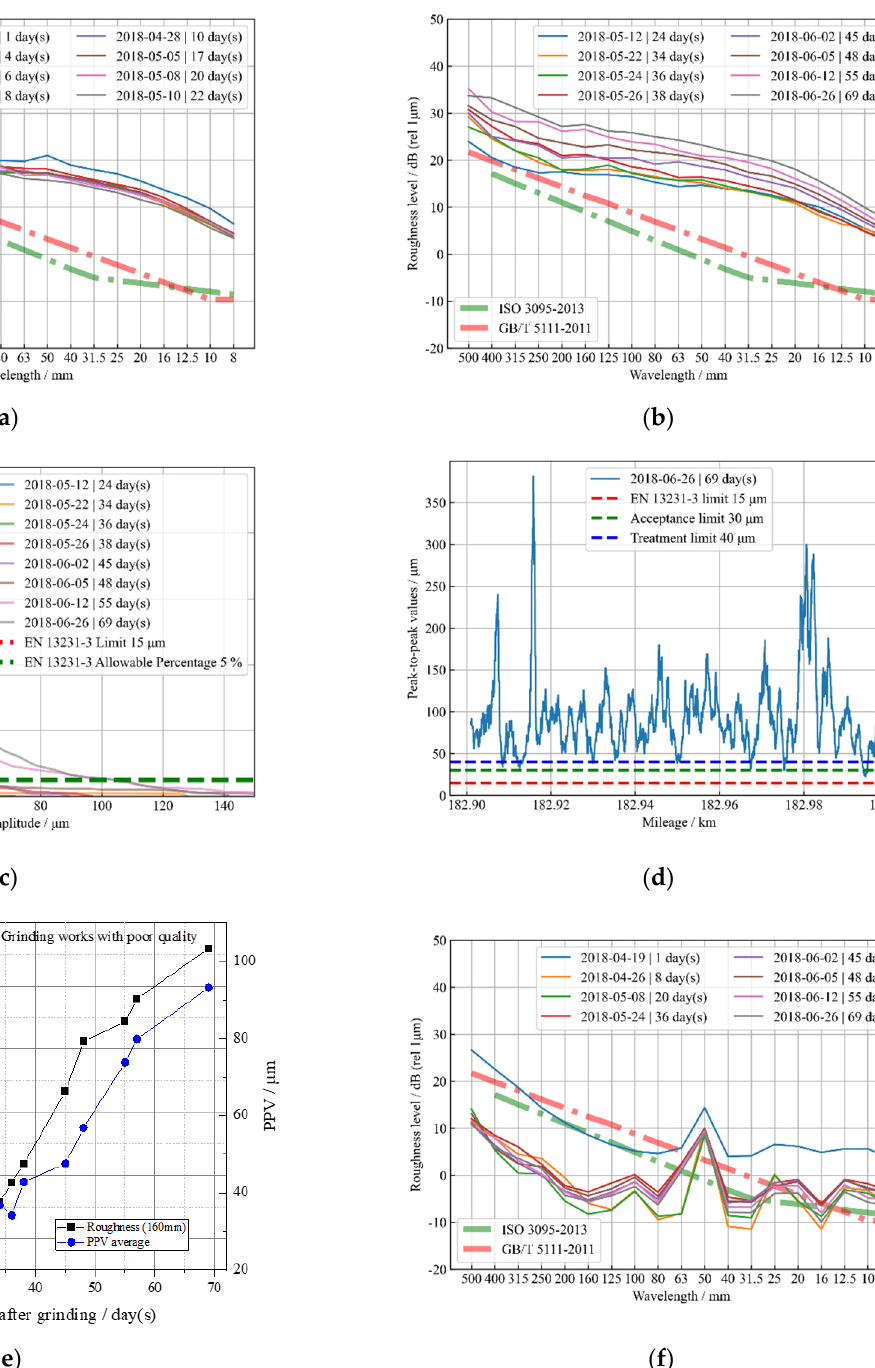
Figure 4. Variation trends in amplitude and frequency domain of corrugation from field test: ( a ) stable state; ( b ) rapid deterioration state; ( c ) CDF of peak-to-peak values during the rapid deterioration period; ( d ) peak-to-peak value of the last field test on inner rail; ( e ) the evolution process of corrugation with dates; ( f ) the trend in one-third octave (outer rail).